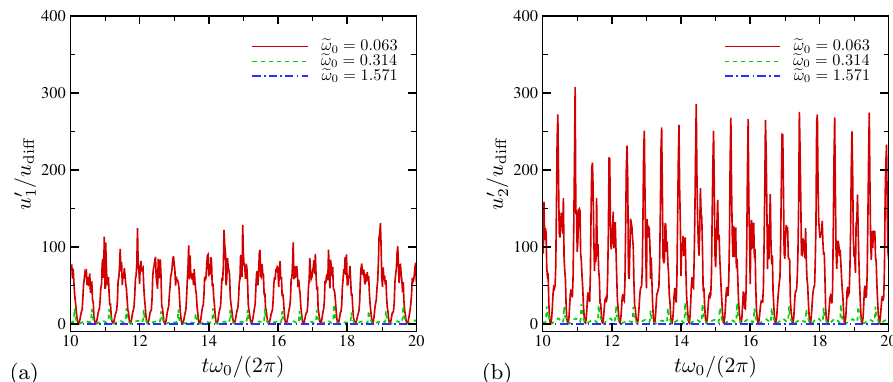
Figure 6. Instantaneous fluctuations of ( a ) horizontal and ( b ) wall-normal velocities. Measurement is made at the channel centerline, and RMS fluctuations are computed with respect to the mean in the horizontal direction.